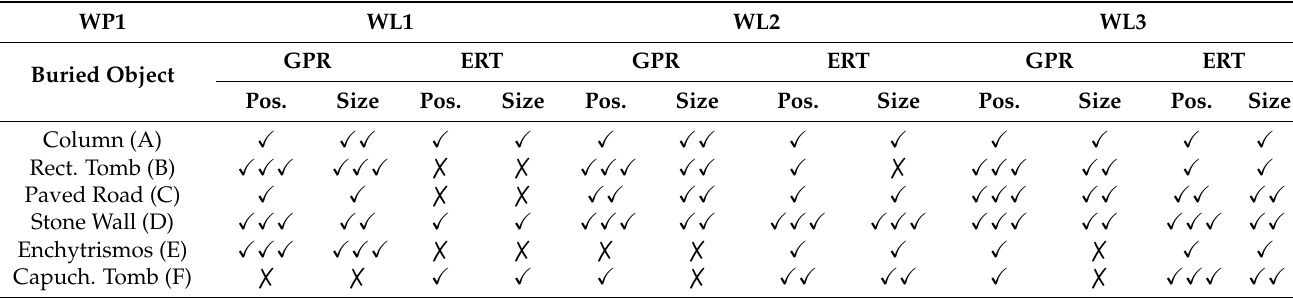
As summarized in Table 3, GPR has permitted to quantitatively characterize, with high accuracy, the sizes of the buried objects when the strong geophysical contrast occurs as in the case of WL1, while the lower attenuation of WL2 and WL3 makes the identifica- tion of the structures more difficult. Regarding ERT, the higher water content of WL1 do Table 3. Comparison between the expected and geophysical results for the detection of the buried Table 3. Comparison between the expected and geophysical results for the detection of the buried Table 3. Comparison between the expected and geophysical results for the detection of the buried not allow to reconstruct the real shape of the buried objects, while in WL2 and WL3, the object in terms of position and size for WL1, WL2, and WL3 in WP1. object in terms of position and size for WL1, WL2, and WL3 in WP1. object in terms of position and size for WL1, WL2, and WL3 in WP1. Table 3. Comparison between the expected and geophysical results for the detection of the buried Table 3. Comparison between the expected and geophysical results for the detection of the buried results are encouraging for real application in the archaeological field. object in terms of position and size for WL1, WL2, and WL3 in WP1. WP1 WL1 Table 3. Comparison between the expected and geophysical results for the detection of the buried Table 3. Comparison between the expected and geophysical results for the detection of the buried Table 3. Comparison between the expected and geophysical results for the detection of the buried Table 3. Comparison between the expected and geophysical results for the detection of the buried Table 3. Comparison between the expected and geophysical results for the detection of the buried Table 3. Comparison between the expected and geophysical results for the detection of the buried Table 3. Comparison between the expected and geophysical results for the detection of the buried Table 3. Comparison between the expected and geophysical results for the detection of the buried Table 3. Comparison between the expected and geophysical results for the detection of the buried object in terms of position and size for WL1, WL2, and WL3 in WP1. object in terms of position and size for WL1, WL2, and WL3 in WP1. object in terms of position and size for WL1, WL2, and WL3 in WP1. object in terms of position and size for WL1, WL2, and WL3 in WP1. GPR ERT object in terms of position and size for WL1, WL2, and WL3 in WP1. object in terms of position and size for WL1, WL2, and WL3 in WP1. object in terms of position and size for WL1, WL2, and WL3 in WP1. Table 3. Comparison between the expected and geophysical results for the detection of the buried WP1 WL2 object in terms of position and size for WL1, WL2, and WL3 in WP1.